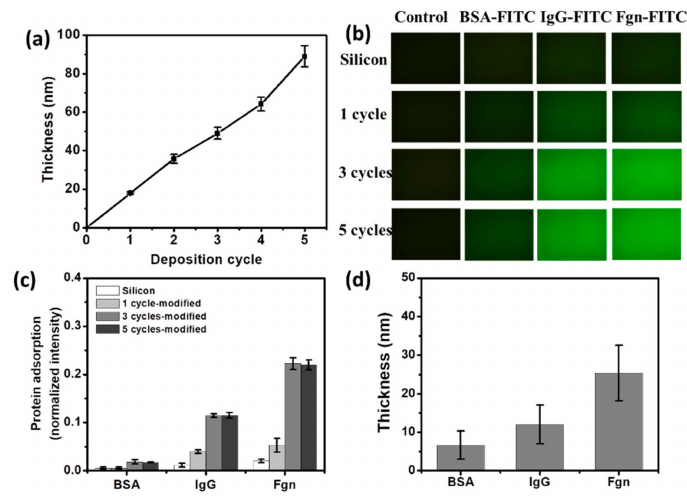
Figure 1. Quantitative characterization of the tannic acid (TA) coating and model protein adsorption. ( a ) Thickness of the TA coating on a silicon slide as a function of deposition cycle number measured by spectroscopic ellipsometry; ( b ) Model protein adsorption on the TA-coated silicon slide. ( c ) Model protein adsorption on the silicon slide and TA-coated silicon slide with di ff erent cycles; ( d ) Protein layer thickness on the TA-coated silicon slide with five cycles.